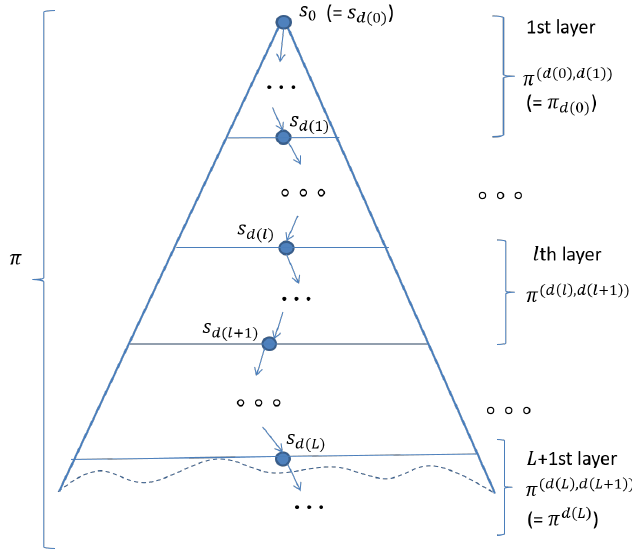
Figure 3. L + 1 layer division of the reachable state